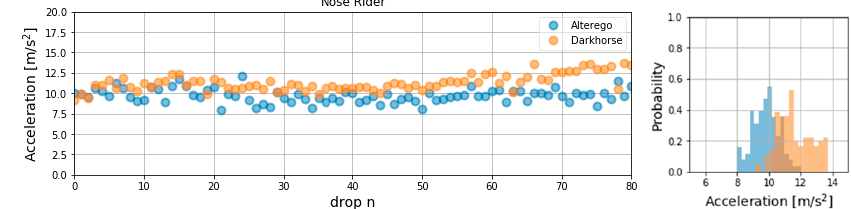
Figure 5. Accelerations measured on the weight (mimicking the rider’s foot) from weight drop test. ( Left ) Peak values for each hit. ( Right ) histogram of the